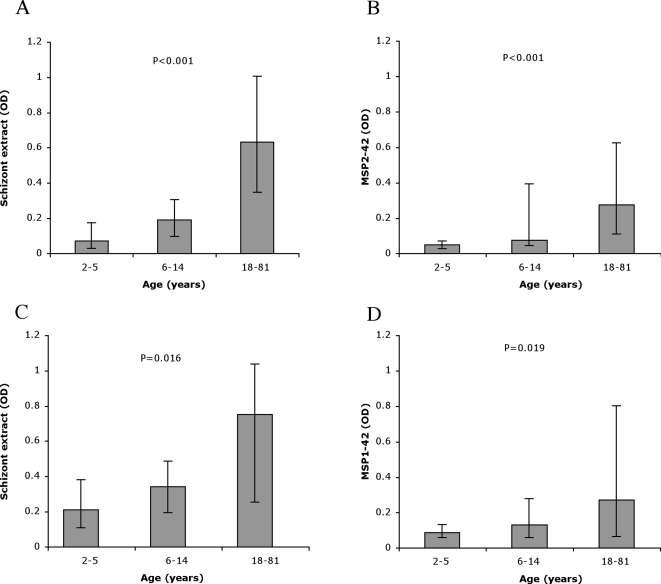
Levels of IgG to schizont protein extract and recombinant MSP1-42, according to age and parasitemic status, among samples from the Ngerenya 1998 cohort.A, B: Median absorbance (Optical Density, OD) to schizont protein extract and MSP1-42, respectively, for aparasitemic participants (n = 91). C, D: Median absorbance to schizont protein extract and MSP1-42, respectively, for parasitemic participants (n = 59). Sera were used at a dilution of 1∶1000. Error bars represent the inter-quartile range. P values were calculated using a Kruskal-Wallis test. All samples were tested in duplicate. The difference in median IgG levels for aparasitemic compared to parasitemic participants was not significant for schizont extract or MSP1-42 (P = 0.082 and P = 0.14, respectively).